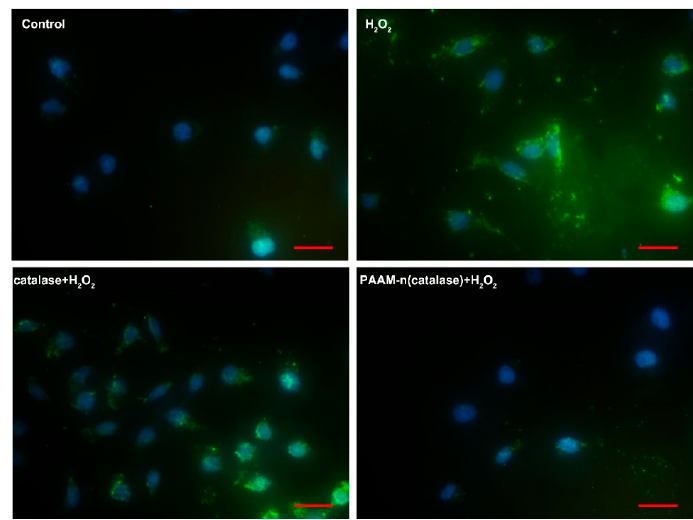
Figure 6. The reactive oxygen species (ROS) concentration in 4T1 cells that were treated with H 2 O 2 , catalase/PLA-coated titanium dioxide plate/H 2 O 2 , and PAAM-n(catalase)/PLA-coated titanium dioxide plate/H 2 O 2 . The bar was 20 μ m.